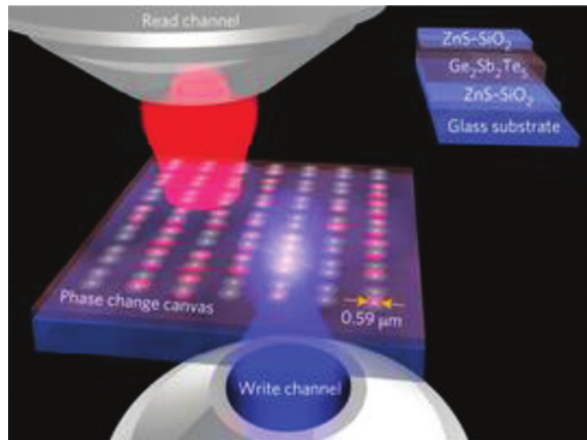
Figure 9: Reconfigurable metasurface consisting of a PCM sub- strate. Reprinted by permission from Macmillan Publishers Ltd: Nature Photonics [159], copyright